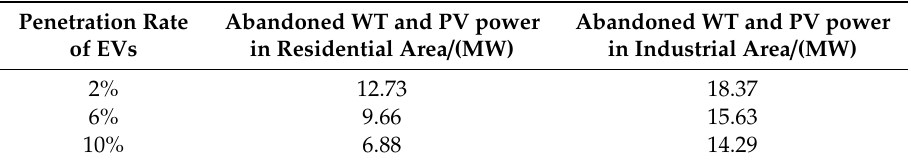
Table 5. Abandoned WT and PV power in functional areas under di ff erent penetration rates of EVs. Penetration Rate Abandoned WT and PV power Abandoned WT and PV power of EVs in Residential Area / (MW)